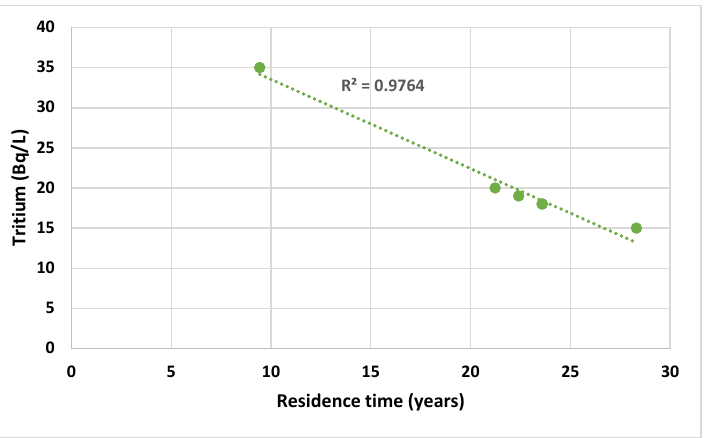
Figure 6. Activity concentration of tritium ( 3 H) in groundwaters with variable residence time from the West Rand area ( n = 6).